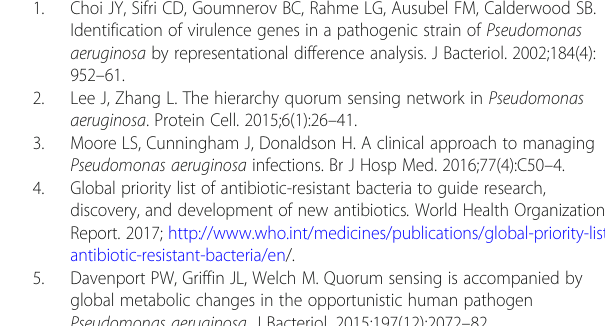
Additional file 1: Table S1. List of down-regulated genes. Table S2. List of up-regulated genes. Table S3. Genes expressed exclusively in PF-exposed P. aeruginosa culture. Table S4. Category-wise list of genes expressed differ- entially in PF-treated P. aeruginosa. Table S5. A comparison of efficacy of Panchvalkal when it is used on P. aeruginosa before infecting C. elegnas , versus, when it is used on C. elegans already infected by P. aeruginosa having no previous exposure to the Panchvalkal extract. (DOCX 91